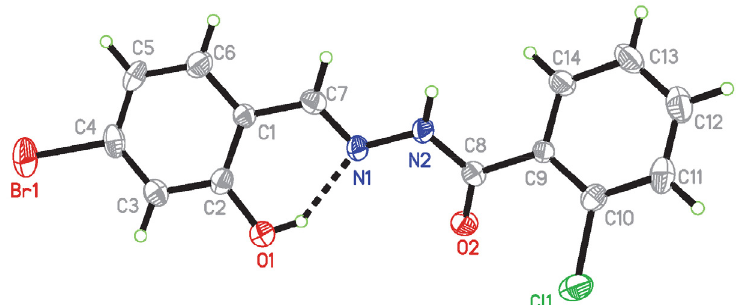
Figure 1. A perspective view of H 2 L 1 with the atom labeling scheme. Thermal ellipsoids are drawn at the 30% probability level. Hydrogen bond is shown as a dotted